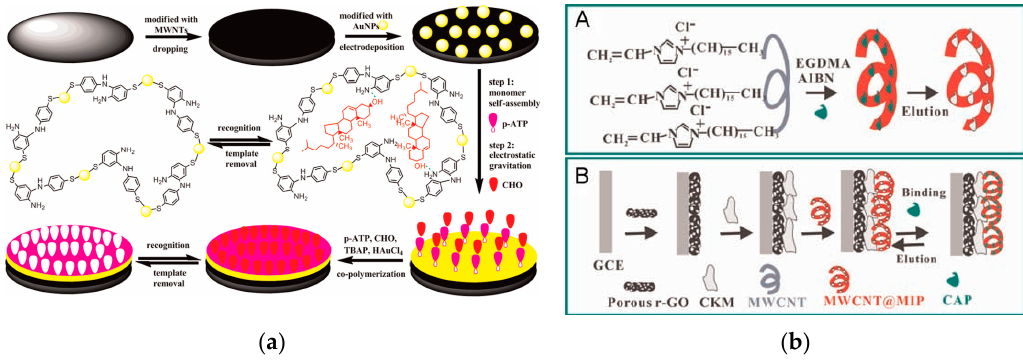
Figure 3. Application of MWNTs in molecularly imprinted biomimetic sensors. ( a ) The preparation procedure of AuNPs/MWNTs/GCE@MIP membrane. Reproduced with permission from